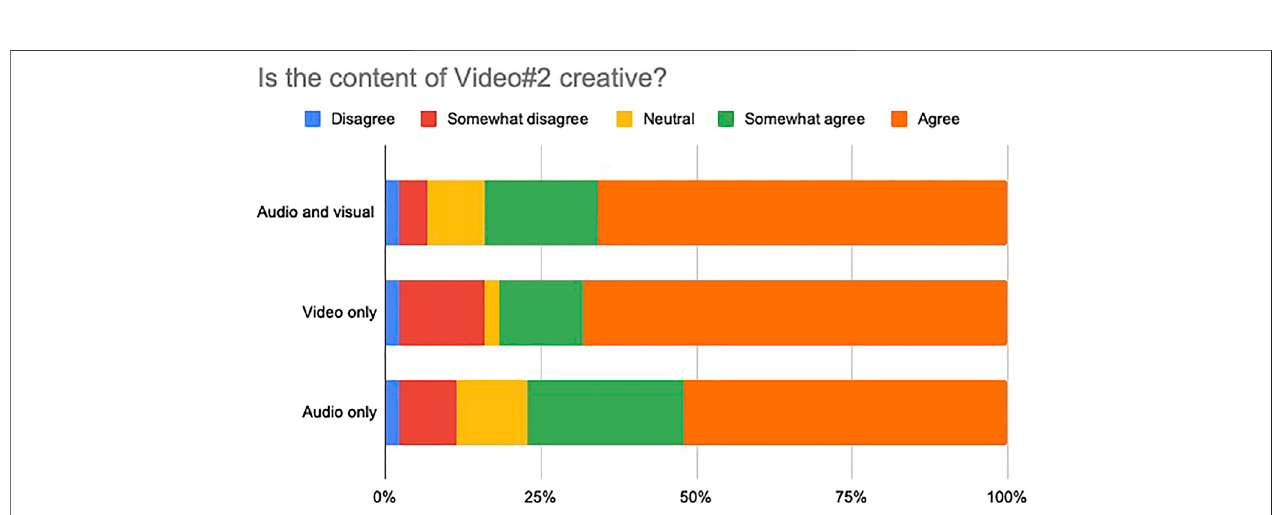
FIGURE 12 | Perceptual evaluation of Video #2. Forty-four participants responded the survey over the internet. All three type of contents: audiovisual, visual only and audio only, were judged to be creative by a great majority of participants.